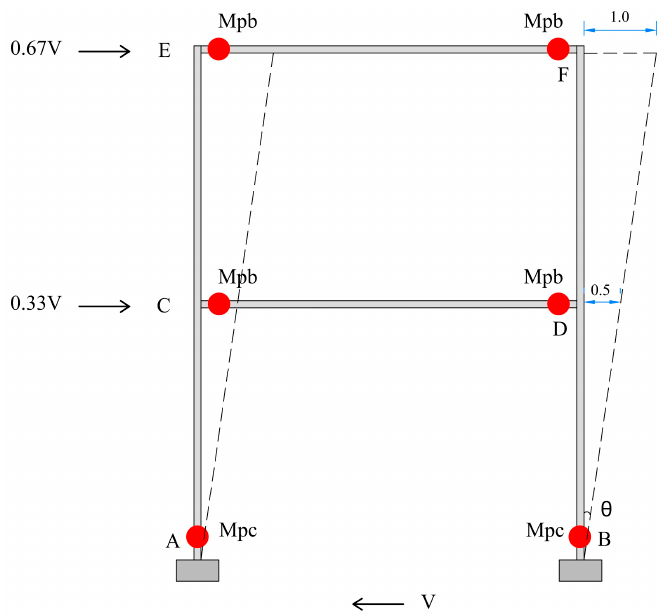
Figure 13. Considered plastic mechanism of the selected frame. For M pb = 133 kN · m, M pc = 81 kN · m, θ = 1/24 rad (1/7.315 rad) and V max equal to 113.62